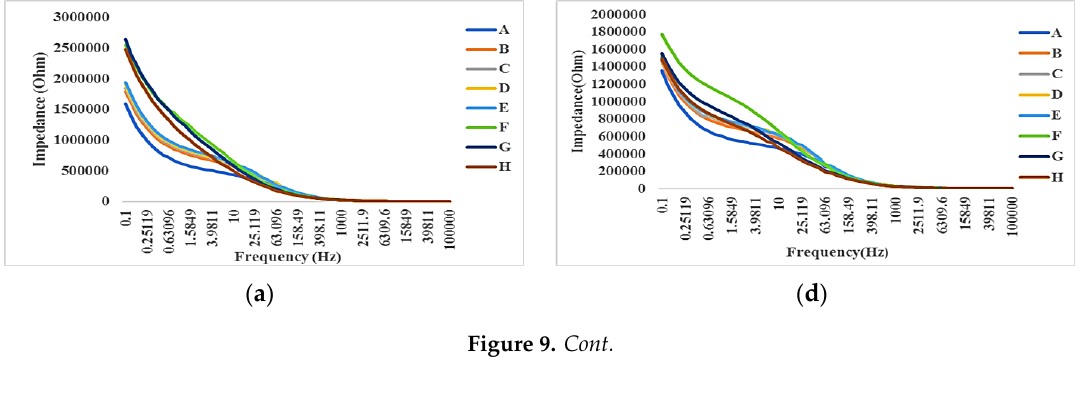
Table 6. A sample of impedance measurement in 8 different times, in the range of 0.1–100 KHz,